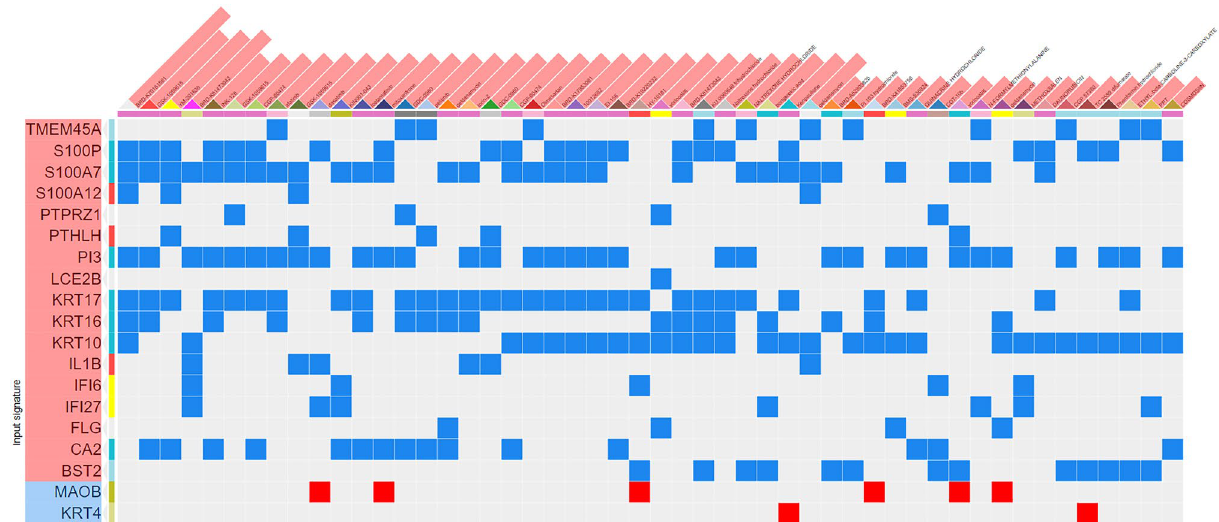
Figure 4. Potential drug target search from shared DEGs using the L1000 CDS 2 tool on the LINCS Program platform. Genes are represented in rows and drugs in columns, with overexpressed genes colored red and underexpressed genes in blue. Colored squares represent drug-gene interactions, with blue cells representing inhibition and red cells representing gene